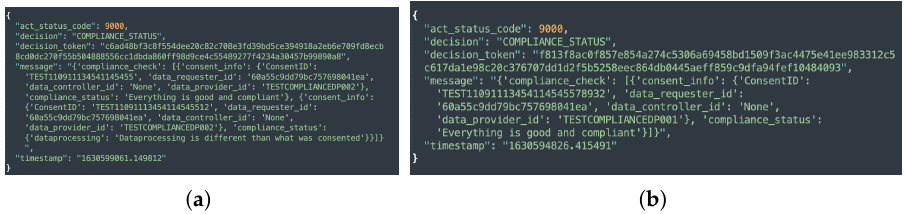
Figure 13. Compliance check response. ( a ) Compliance check based on data provider. ( b ) Compliance check based on a single consent.